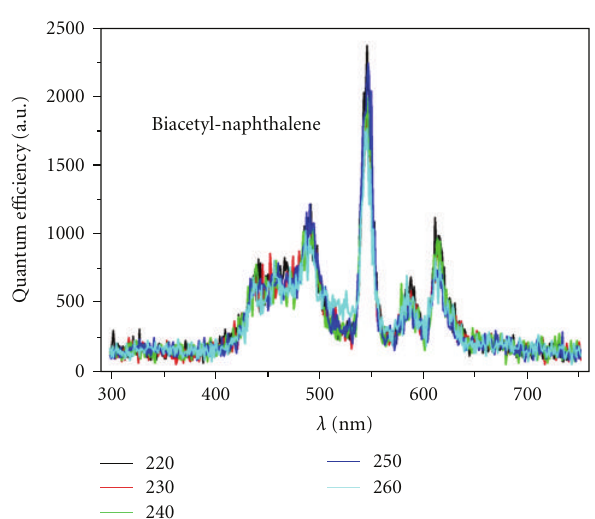
Figure 2: Sensitized fluorescence of biacetyl by naphthalene in liquids at room temperature.